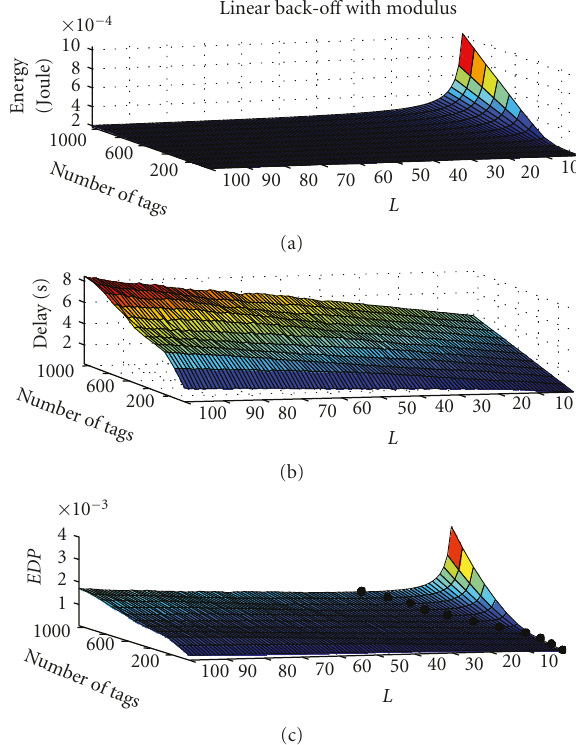
Figure 11: Linear back-o ff algorithm with